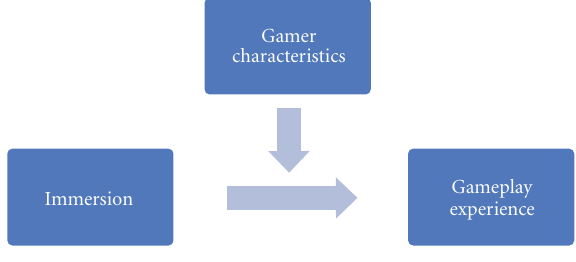
Figure 1: Research